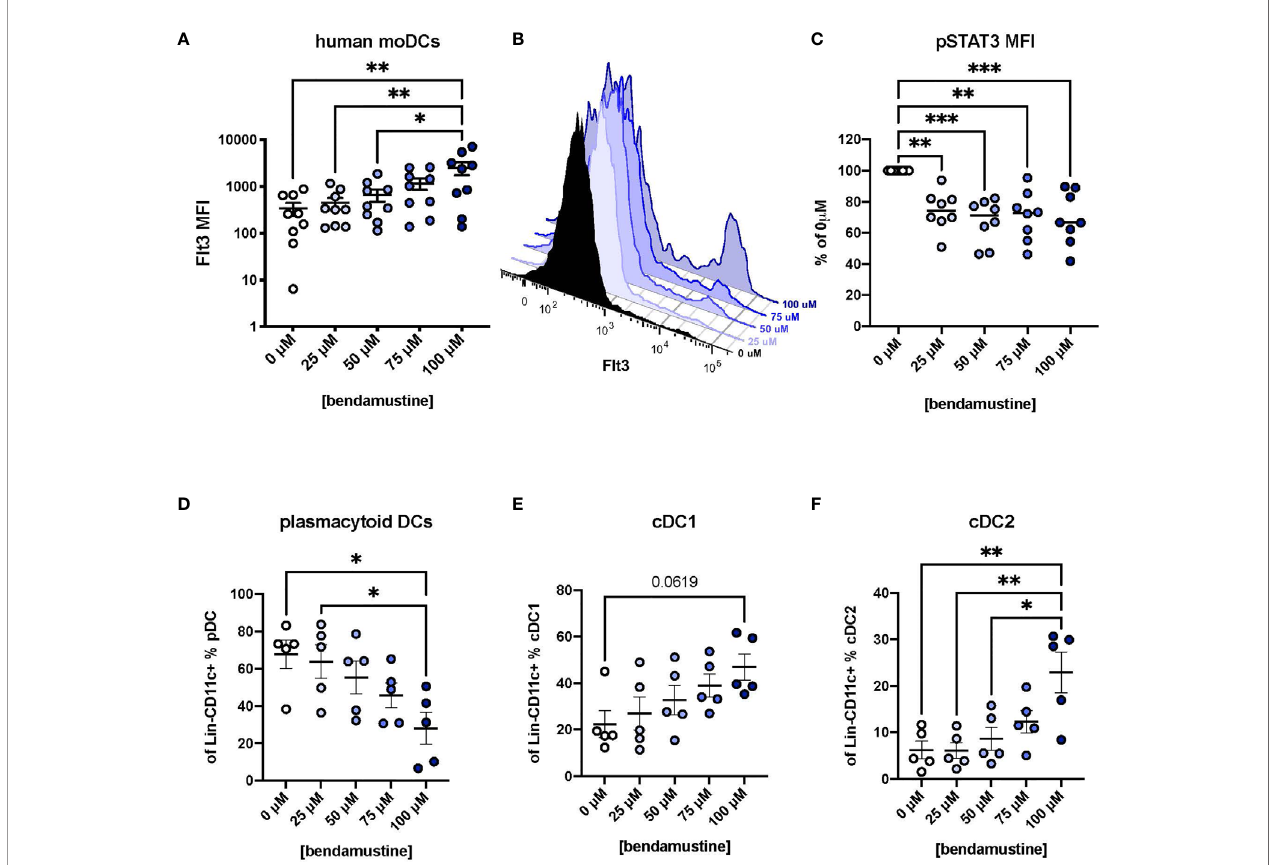
FIGURE 6 | Human DCs exhibit concentration-dependent increase in Flt3 expression following BEN exposure and decreased pSTAT3. Human monocyte-derived DCs (moDCs) were generated following brief exposure to BEN and characterized by fl ow cytometry. Data shown is pooled from 9 independent experiments (n=5-9). (A) Mean Flt3 MFI among human moDCs shown with SEM. (B) Representative histogram of Flt3 expression on BEN-exposed moDCs from a single individual. (C) Mean pSTAT3 MFI normalized to percent of control (0 m M) shown with median. (D) Mean percent of plasmacytoid DCs (Lineage - CD11c + BDCA4 + ) shown with SEM. (E) Mean percent of cDC1 (Lineage - CD11c + BDCA4 - BDCA3 + ) shown with SEM. (F) Mean percent cDC2 (Lineage - CD11c + BDCA4 - BDCA1 + ) shown with SEM. One-way ANOVA and Dunnett ’ s multiple comparisons test were used to determine signi fi cance among groups. *P < 0.05, **P < 0.01, ***P <